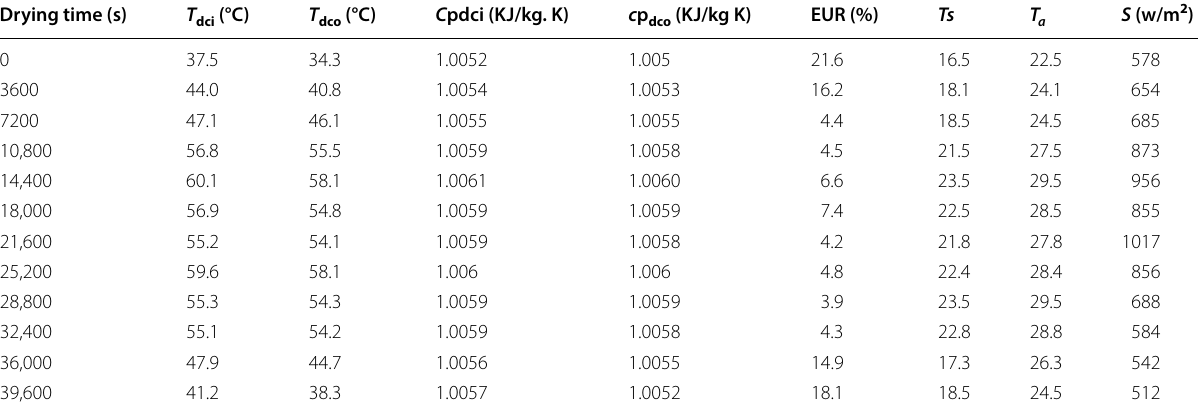
Table 18 Result energy analysis potato 3rd day